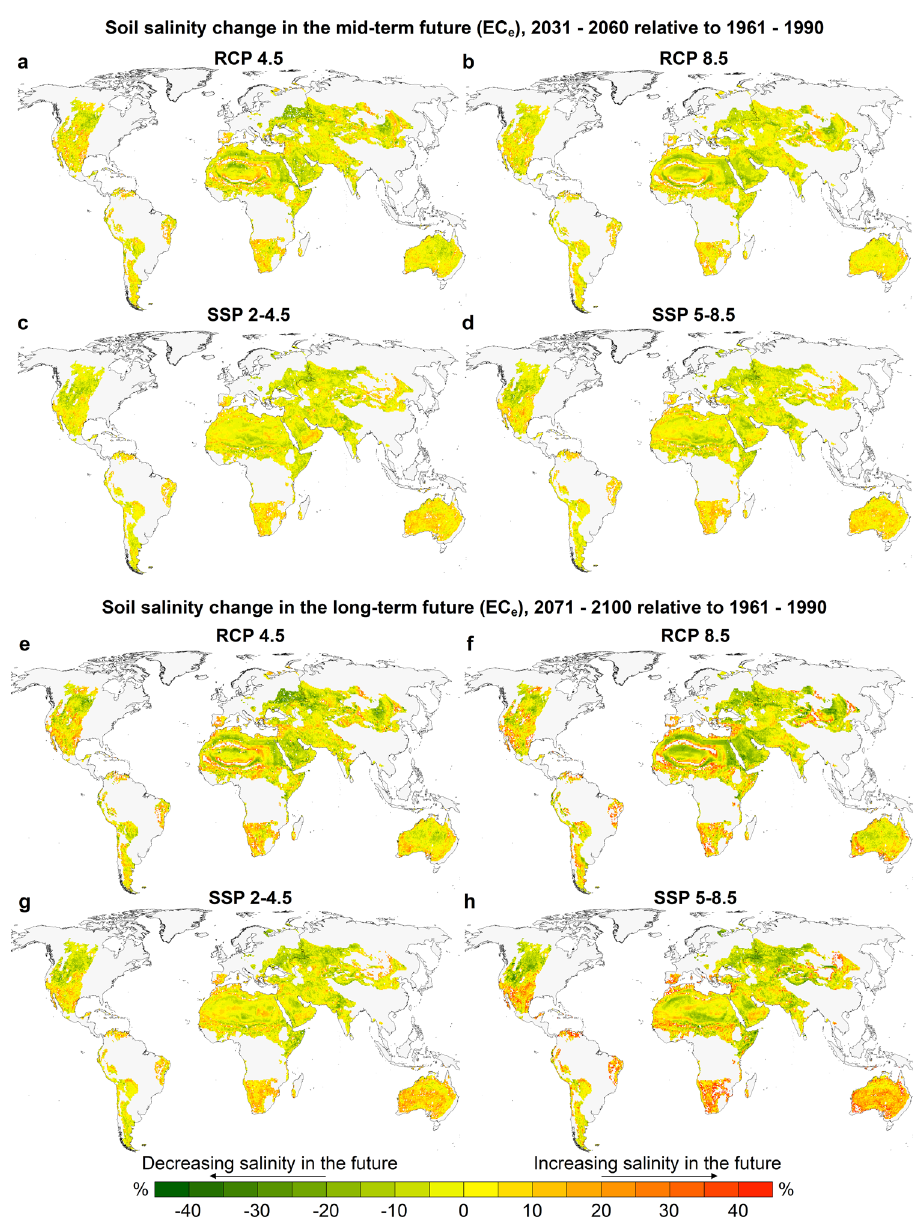
Fig. 1 Multi-model ensemble mean of the change in predicted soil salinity represented by saturated paste electrical conductivity (EC e ) in the mid- and long-term futures, relative to the reference period (1961 – 1990) under different greenhouse gas concentration trajectories. a – d Mid-term prediction of changes in EC e (2031 – 2060). e – h Long-term prediction of changes in EC e (2071 – 2100). The average of the predictions to the depth of 1 m were used for calculations of salinity change. At each map cell (pixel) and based on each GCM, we calculated the mean of soil salinity for the reference, mid-, and long- term future periods and then computed the relative change as: (Future mean − Reference mean)/Reference mean; the percentage value of each cell represents the multi-GCM mean of the calculated relative changes presented by the colour map. Positive values indicate an increase in soil salinity while the negative values are indicative of a decreasing